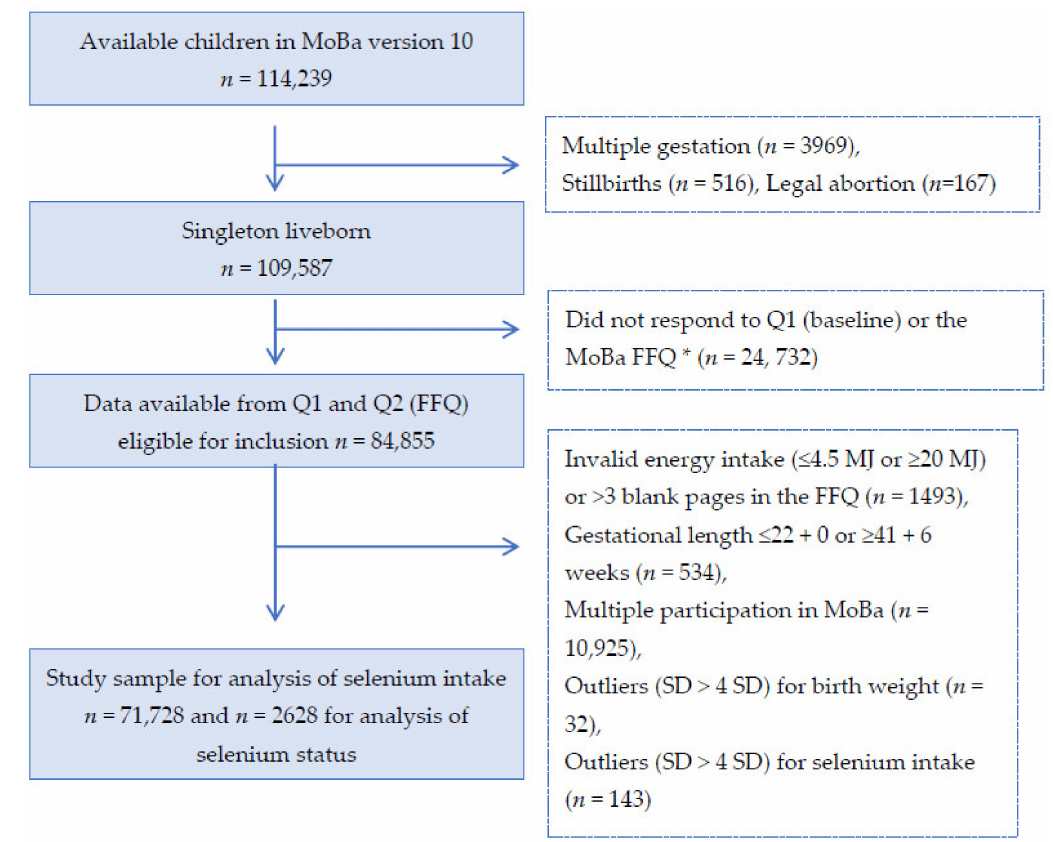
Figure 1. Flow chart over the study population. * The current food frequency questionnaire (FFQ) was not used before 2002, explaining the large drop of numbers from box 2 to